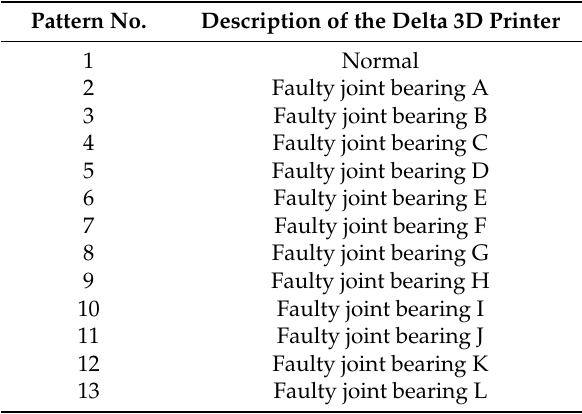
Table 1. Condition patterns set in the experiments.